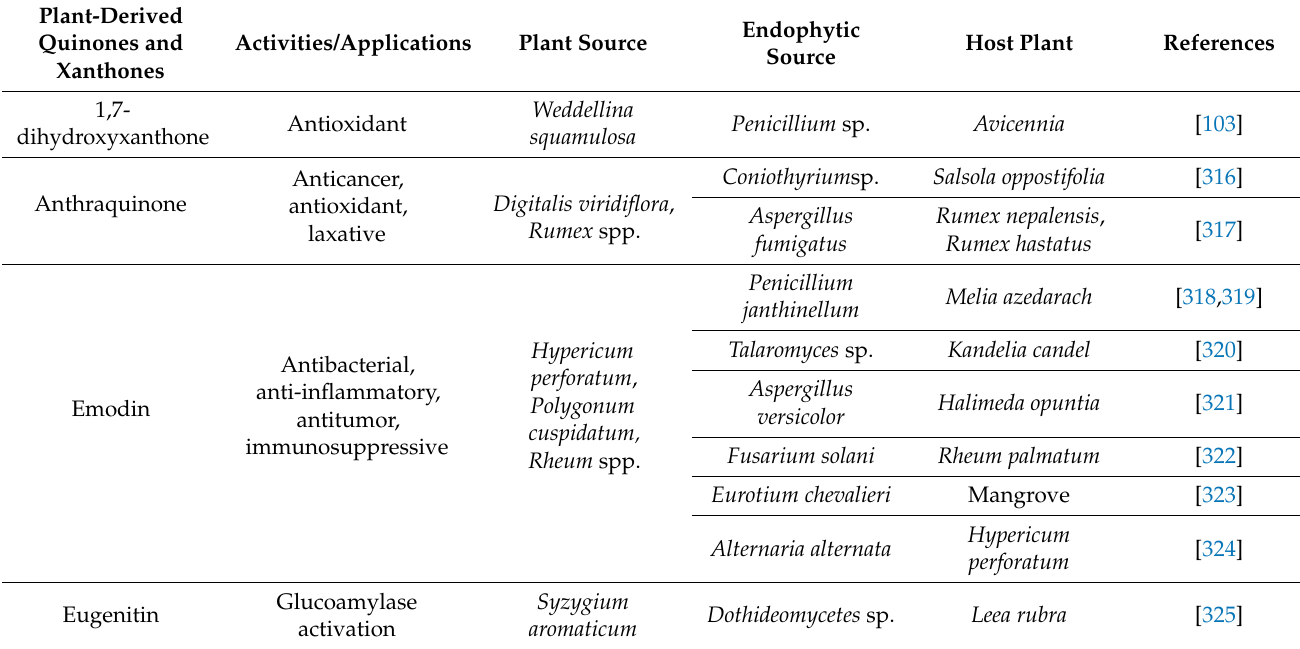
Table 7. Plant-derived quinones and xanthones produced by endophytic fungi.